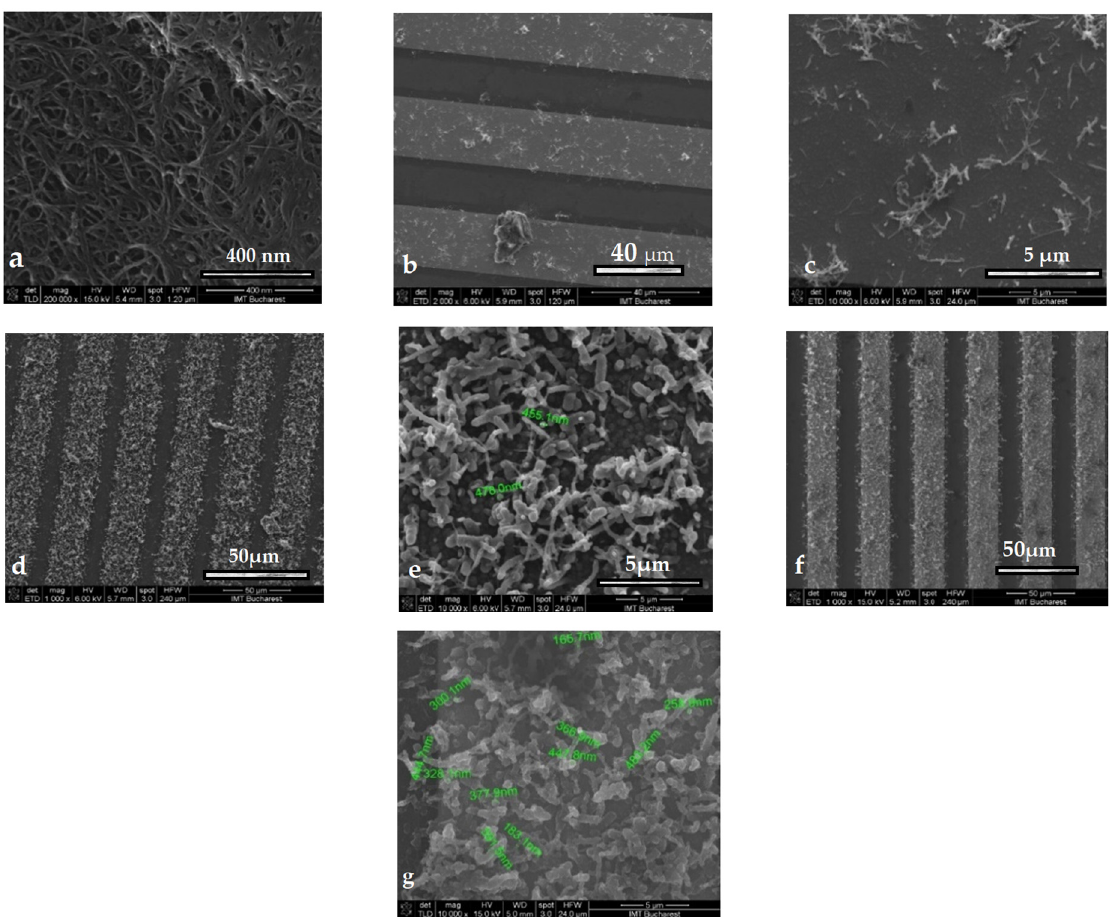
Figure 4 Figure 4. SEM images for ( a ) single-walled carbon nanotubes (SWCNTs) on interdigitated electrodes (IDEs); ( b ) and ( c ) 15th cycle electropolymerization (EP) of polyaniline:poly(4-styrenesulfonate) (PANI:PSS)/SWCNTs on IDEs; ( d ) 40th cycle EP of PANI:PSS/SWCNTs on IDEs; ( e – g ) 40th cycle EP of PANI:PSS/SWCNTs/ferrocene (Fc) on IDEs.